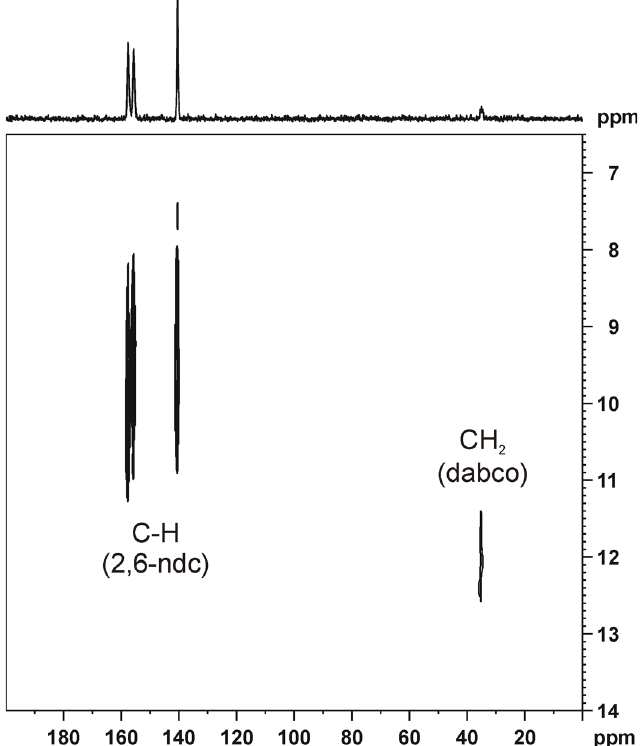
Figure 5. 13 C{ 1 H} HETCOR spectrum of resolvated DUT-8(Ni) (Reproduced with permission from [24], copyright 2012 the Royal Society of Chemistry). The spectrum was measured using FSLG decoupling during the 1 H evolution period t